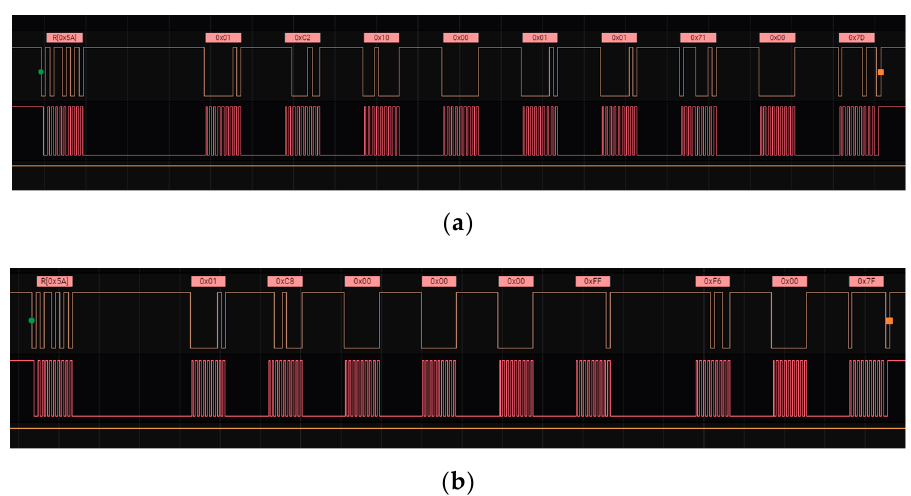
Figure 7. ( a ) Response 0x10 means the sensor is warming up, and ( b ) response 0x00 means the sensor is working well.